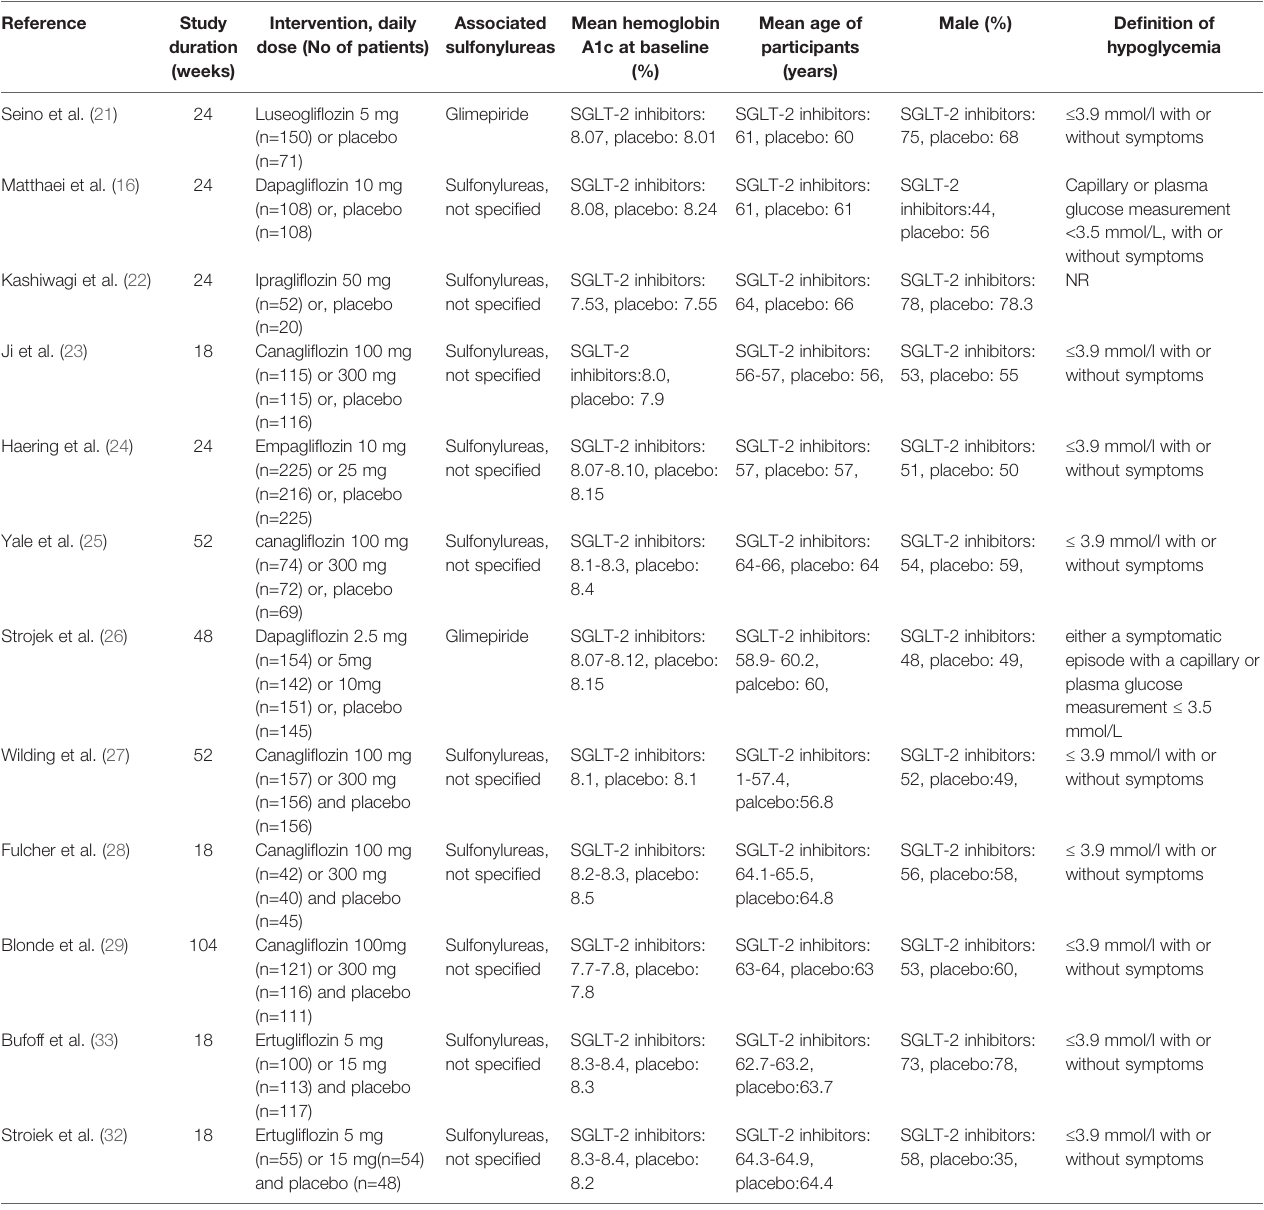
TABLE 1 | Characteristics of included